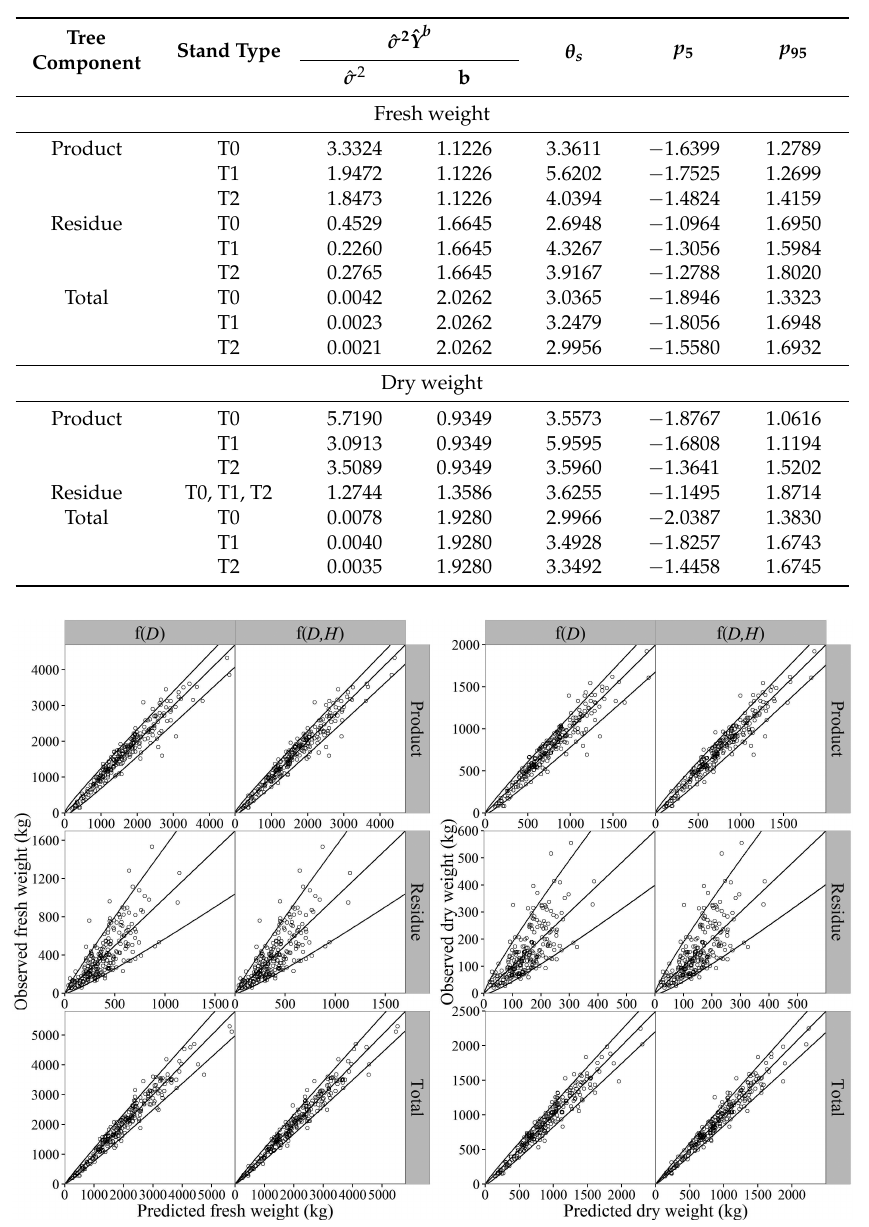
Figure 5. Multi-panel display of observed product, residue and total tree fresh and dry weight plotted against their predicted values from Equations (6) and (8), the one- and two-variable systems of additive equations without incorporating dummy variables for stand types. The diagonal line of unity was shown together with the 90% upper and lower confidence limits of prediction error in each